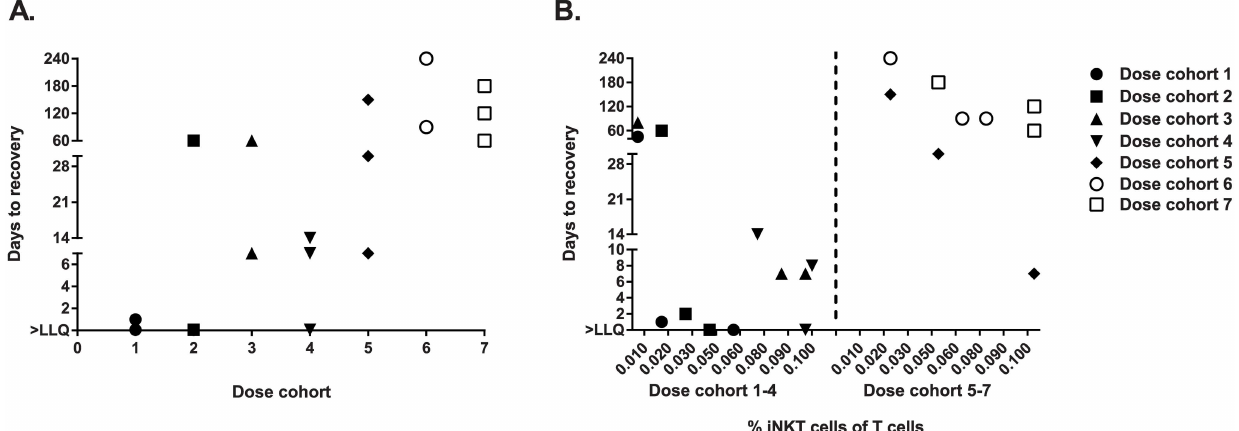
Fig 3. Invariant NKT cell percent of T cells over time. (A) After NKTT120, days to iNKT cell recovery abovethe lower limit of quantification (LLQ) generallyincreasesacross 7 dose cohorts, ( B) Dose cohorts 1–4 and 5–7 by pre-drugiNKT cell levels expressedas percent of T cells. Lower pre-drug iNKT cell level is associatedwith longerrecovery time, especiallyin dose cohorts